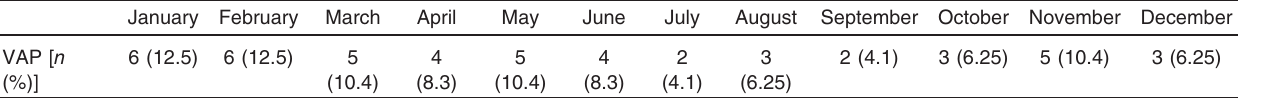
Table 14 Number of patients with ventilator-associated pneumonia in relation to studied